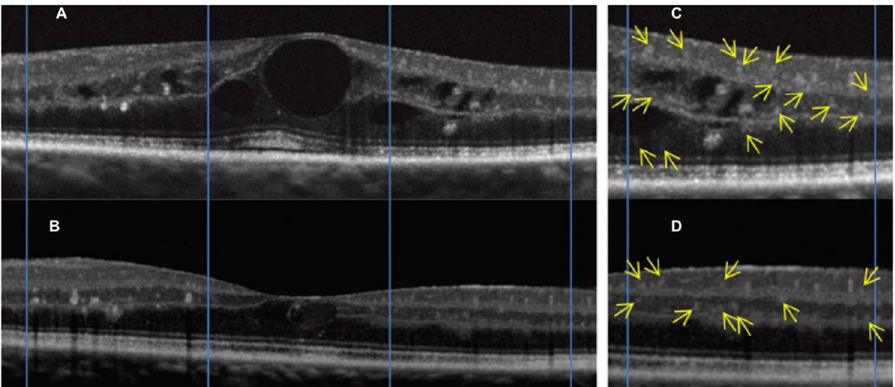
Figure 11. ( A ) Macular OCT linear scan in a patient affected by radiation maculopathy. ( B ) Macular OCT linear follow-up scan performed after intravitreal treatment by dexamethasone implant, showing the resolution of macular edema. ( C ) Magnification of figure A, showing hyperreflective intraretinal foci (yellow arrows). ( D ) Magnification of figure B, showing the reduction of hyperreflective intraretinal foci (yellow arrows).